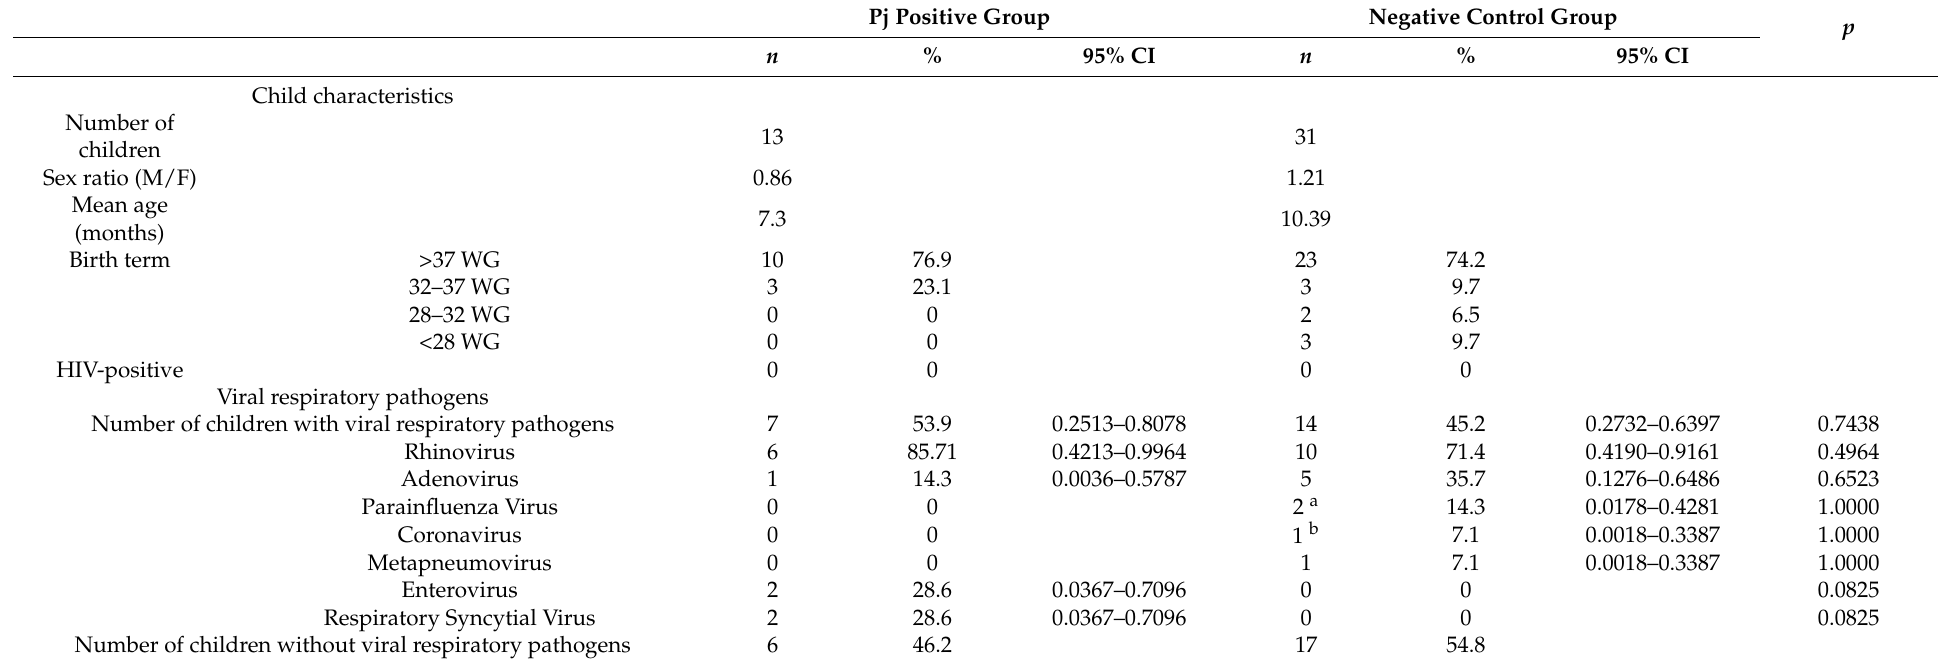
Table 2. Description of viral coinfection in the Pj positive group and the negative control group